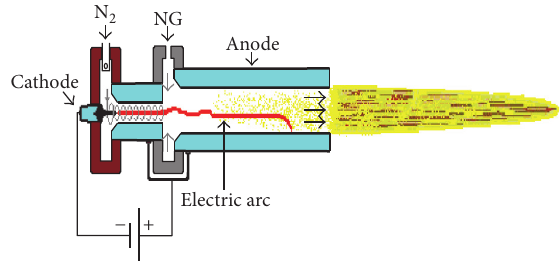
Figure 1: Illustration of the plasma reactor used for thermal cracking of natural gas (NG), composed of a double chamber with N 2 as the working